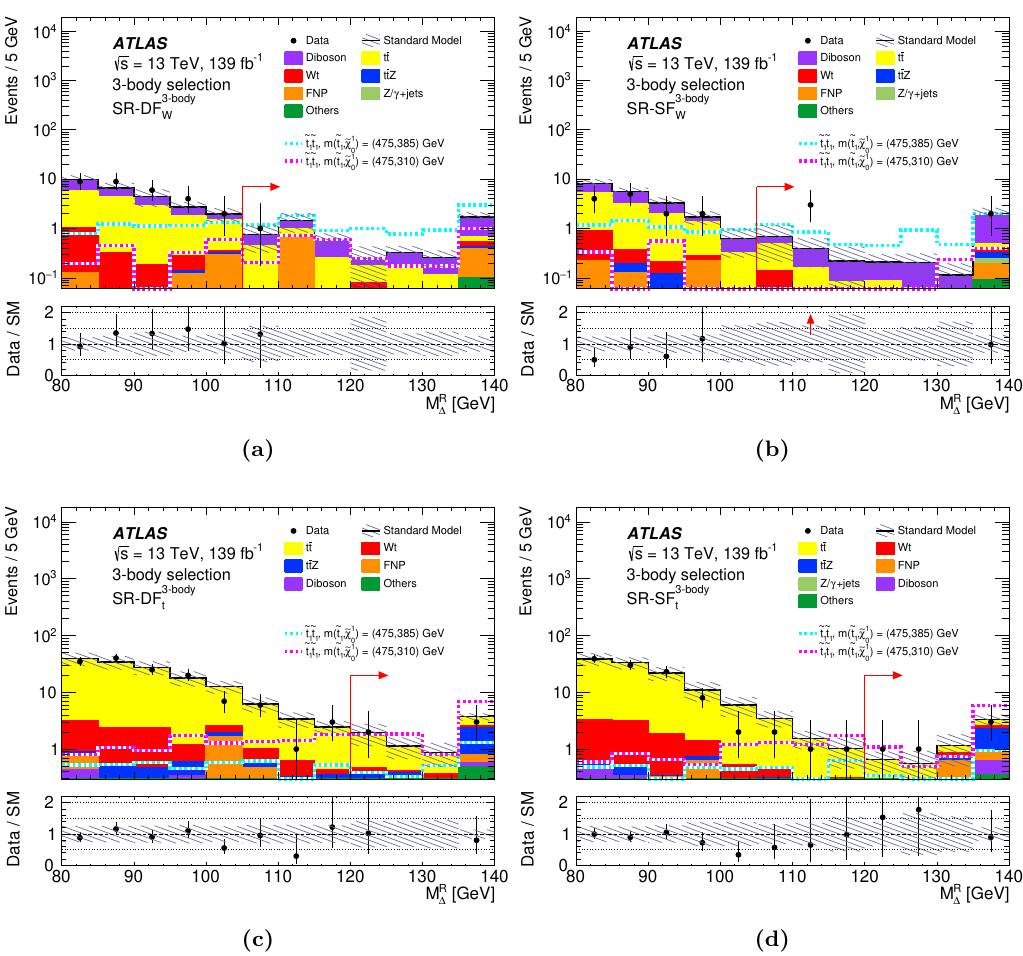
Figure 12 . Three-body selection. Distributions of M R in (a, b) SR 3-body and (c, d) SR 3-body for ∆ t W (left) same-flavour and (right) different-flavour events satisfying the selection criteria of the given SR, except the one for the presented variable, after the background fit. The contributions from all SM backgrounds are shown as a histogram stack. “Others” includes contributions from V V V , tt t , tttt , tt W , tt WW , tt WZ , tt H , and tZ processes. The hatched bands represent the total statistical and systematic uncertainty. The rightmost bin of each plot includes overflow events. Reference top squark pair production signal models are overlayed for comparison. Red arrows in the upper panels indicate the signal region selection criteria. The bottom panels show the ratio of the observed data to the total SM background prediction, with hatched bands representing the total uncertainty in the background prediction; red arrows show data outside the vertical-axis